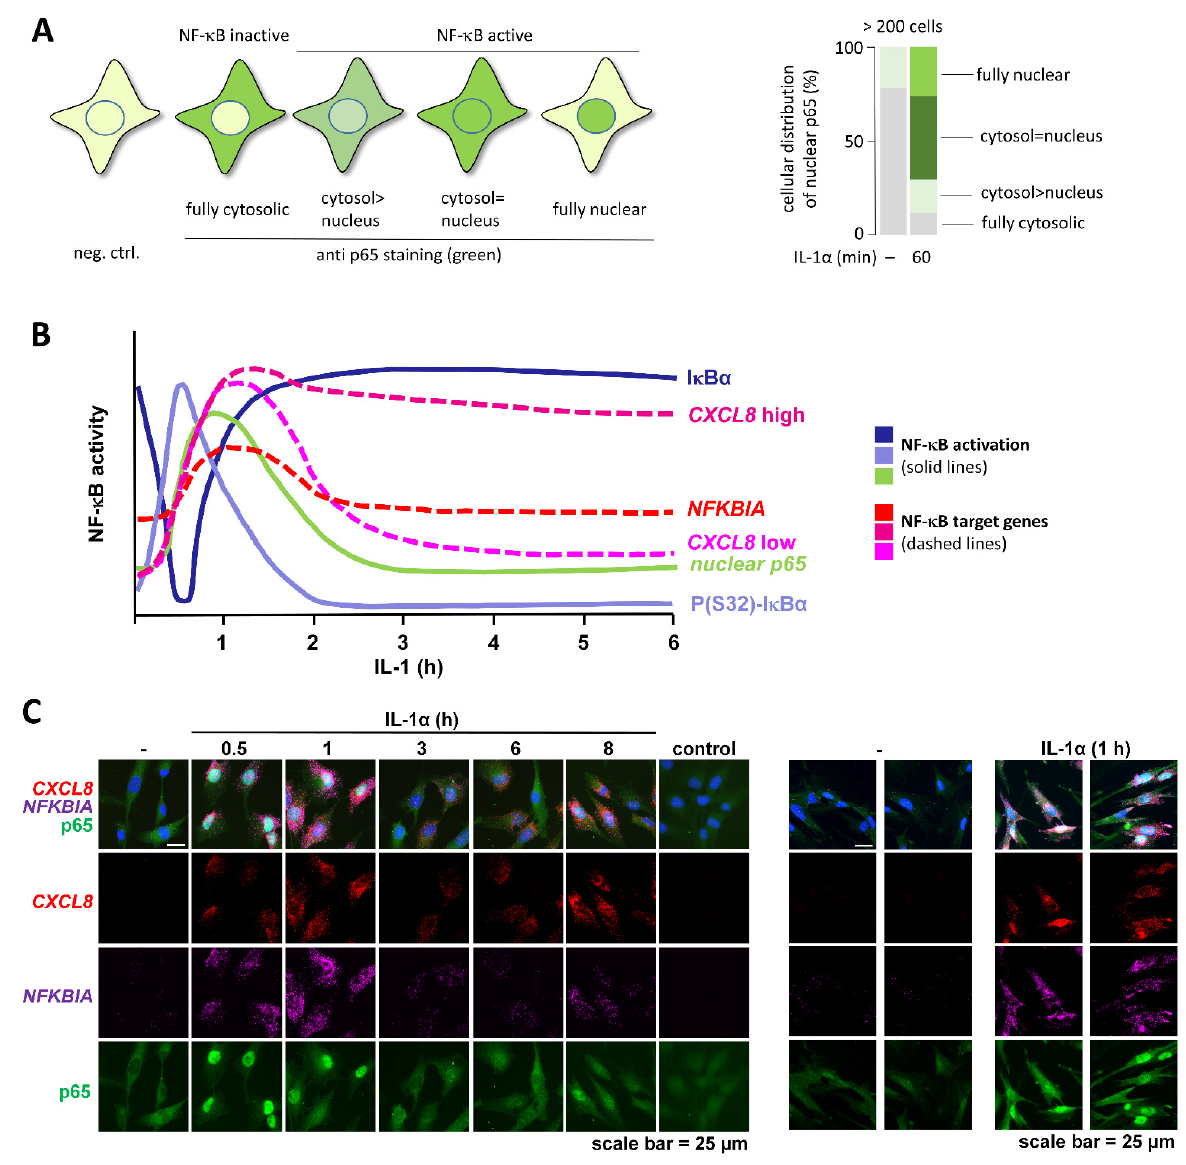
Figure 4. Key assays to determine heterogeneous NF ‐κ B activation states in individual cells. ( A ) Immunofluorescence